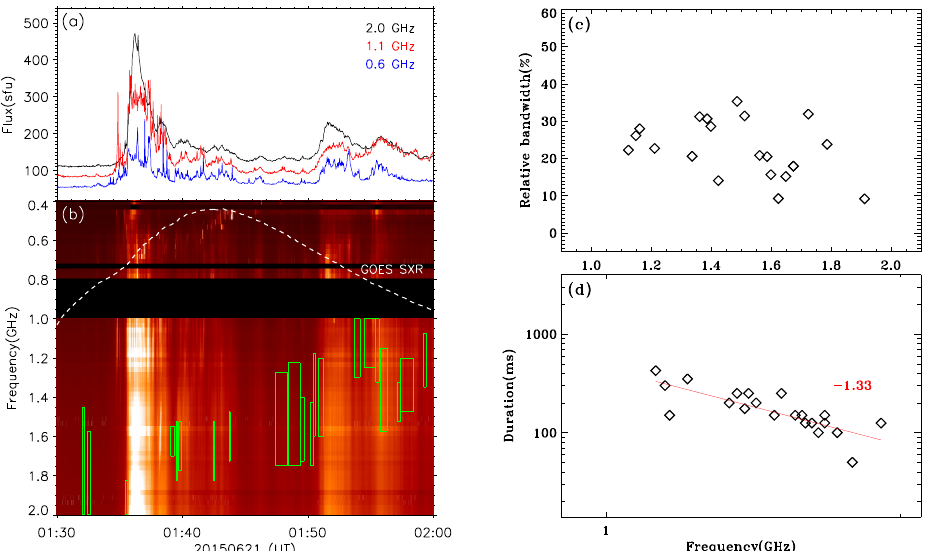
Figure 6. ( a ) The radio flux at 0.6 (blue), 1.1 (red) and 2 (black) GHz by the No.5 antenna of MUSER-I from 01:30 UT to 02:00 UT. ( b ) The RCP spectrum at 0.4–2 GHz observed by the No.5 antenna of MUSER-I. The white dashed line is the GOES flux, and the green boxes cover the temporal and frequency range of QPSs. ( c ) The spectral distribution of the relative bandwidth of the whole group of QPSs. ( d ) The spectral distribution of the duration of the clusters in